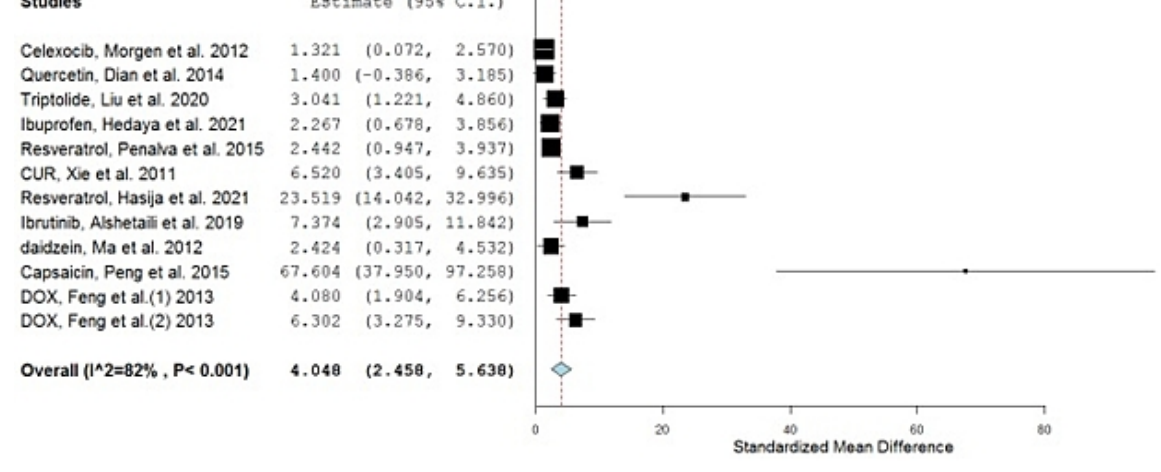
Figure 2. Forest plot of the meta-analyzed